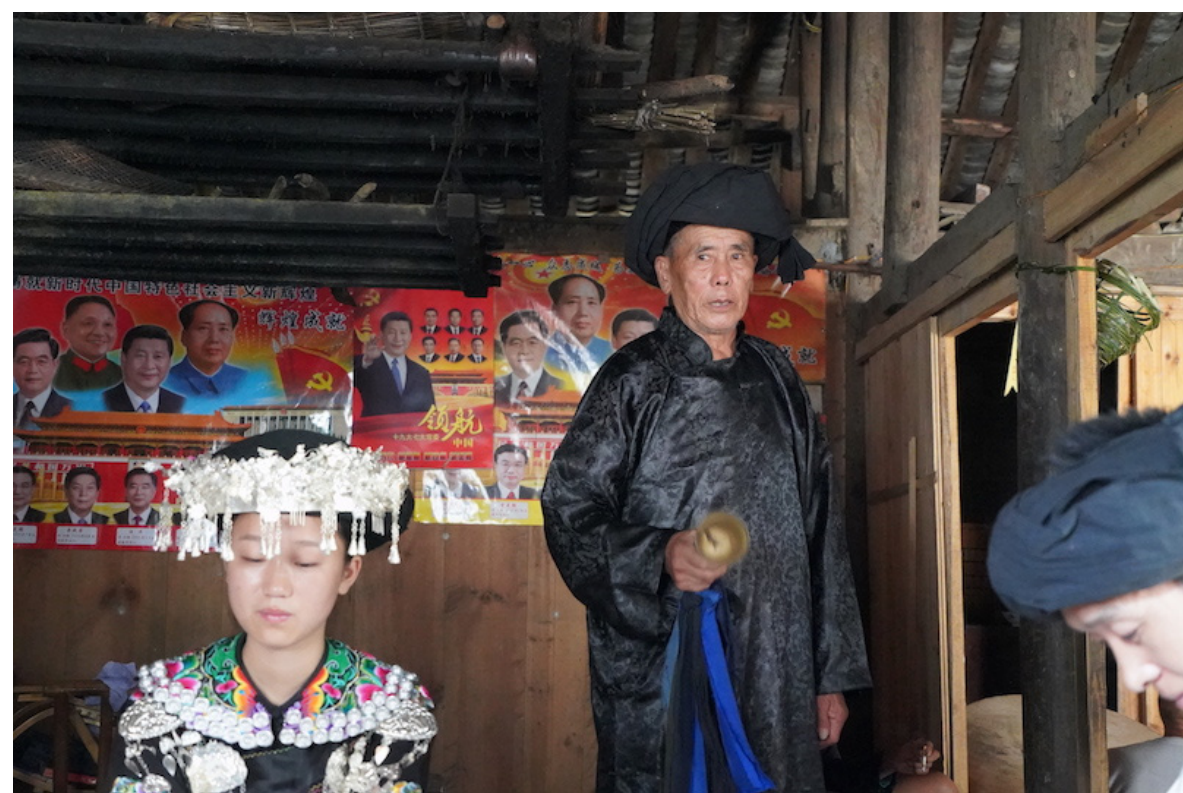
Figure 16. Badai Tian in badaixiong regalia and ringing a bell to offer the spirits the two couples. (Photo: Thomas Riccio).